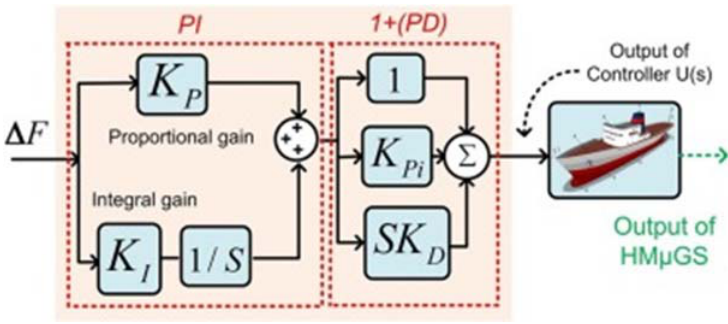
Figure 7. PI-(1 + PD) Controller, parameters require optimization.